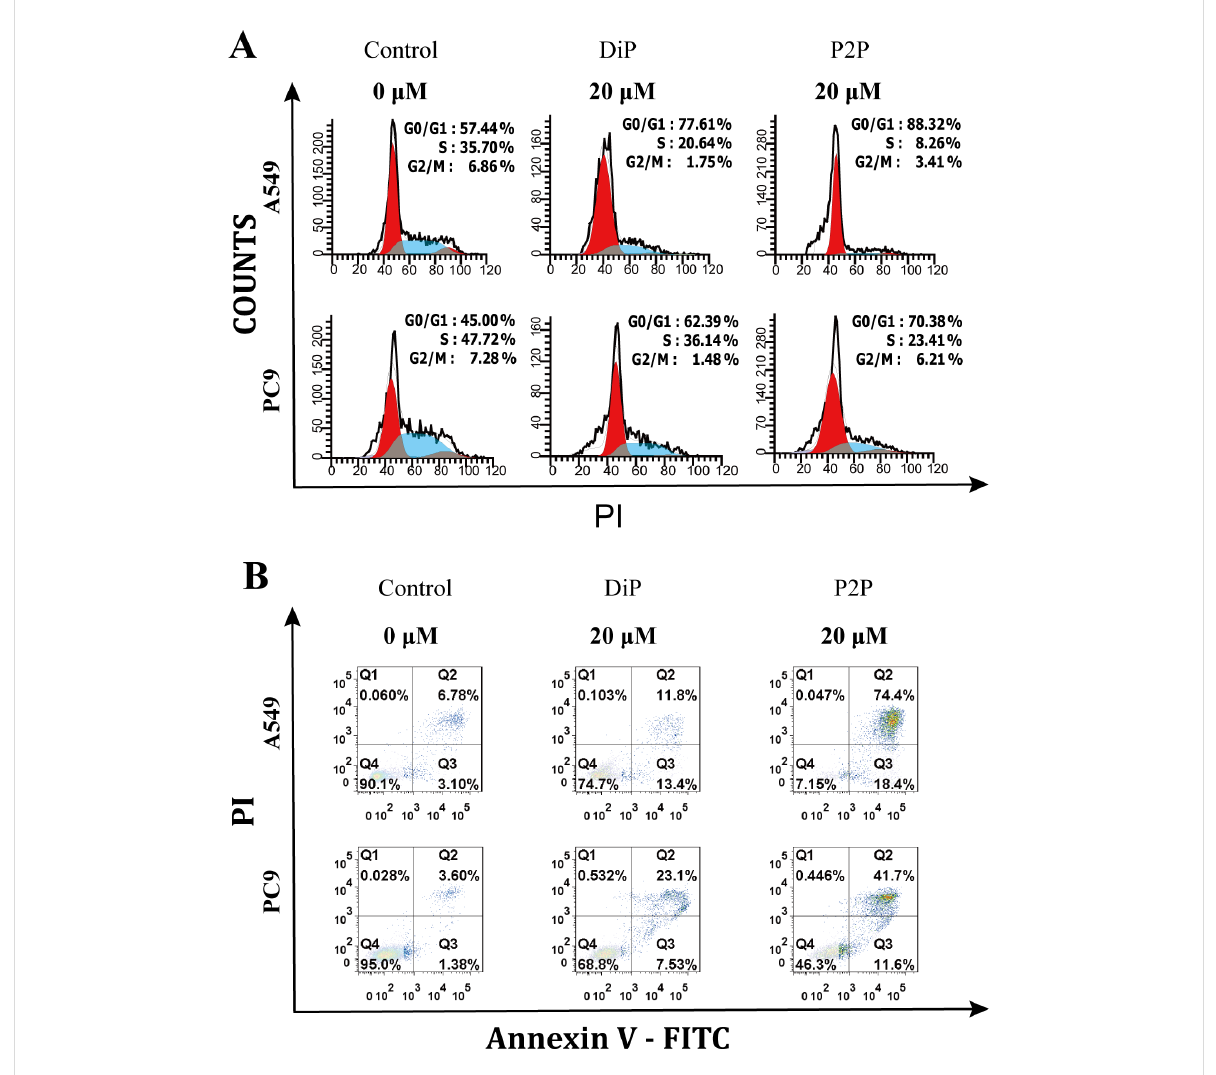
Figure 5: (A) Cell cycle analysis of A549 and PC9 cells after treated with DiP and P2P for 72 h. (B) Cell apoptosis analysis of A549 and PC9 cells after treated with DiP and P2P for 72 h.